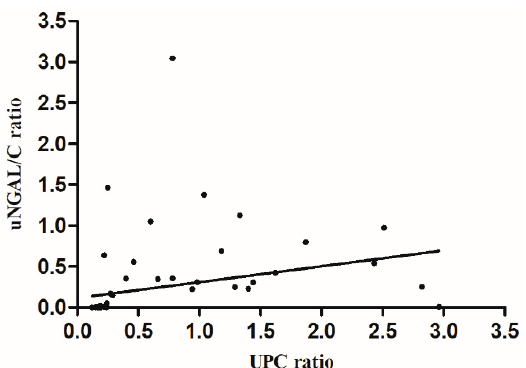
Figure 2. Graphic representation of Spearman correlation between uNGAL / C and UPC (rs = 0.485, p = 0.005).